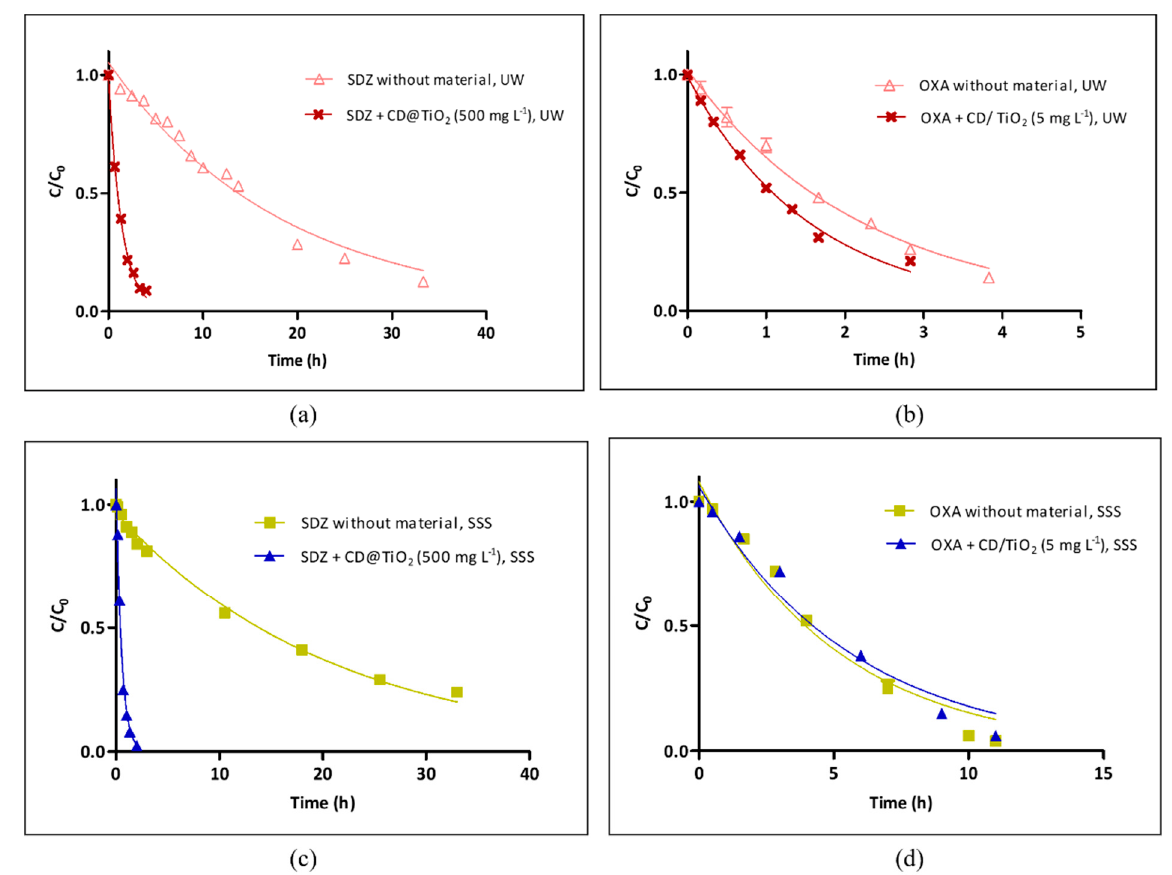
Figure 8. Experimental results on the kinetics of antibiotics photodegradation ( C i = 10 mg L − 1 ) in the presence and absence of the photocatalyst, together with the curves of pseudo first-order decay fitted to the data by nonlinear regression obtained for ( a ) SDZ in UW; ( b ) OXA in UW; ( c ) SDZ in SSS; and ( d ) OXA in SSS (Note that, for most of the experimental points, error bars are too small to be visible). Table 2. Data on pseudo-first order rate constants ( k (h − 1 )), determination coefficients ( r 2 ),